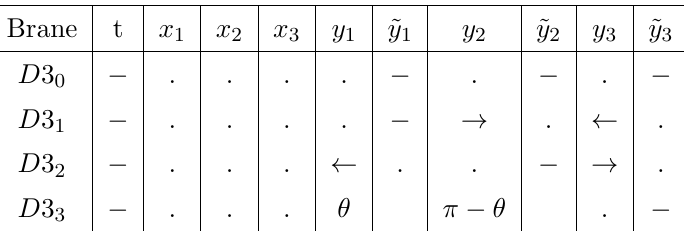
Table 2 . D3-brane con(cid:12)guration: Neumann and Dirichlet directions are lines and dots respectively. The arrow distinguishes between the (cid:18) = 0 (right arrow) and (cid:18) = (cid:25) (left arrow) case. The angle is taken with respect to the non tilded y